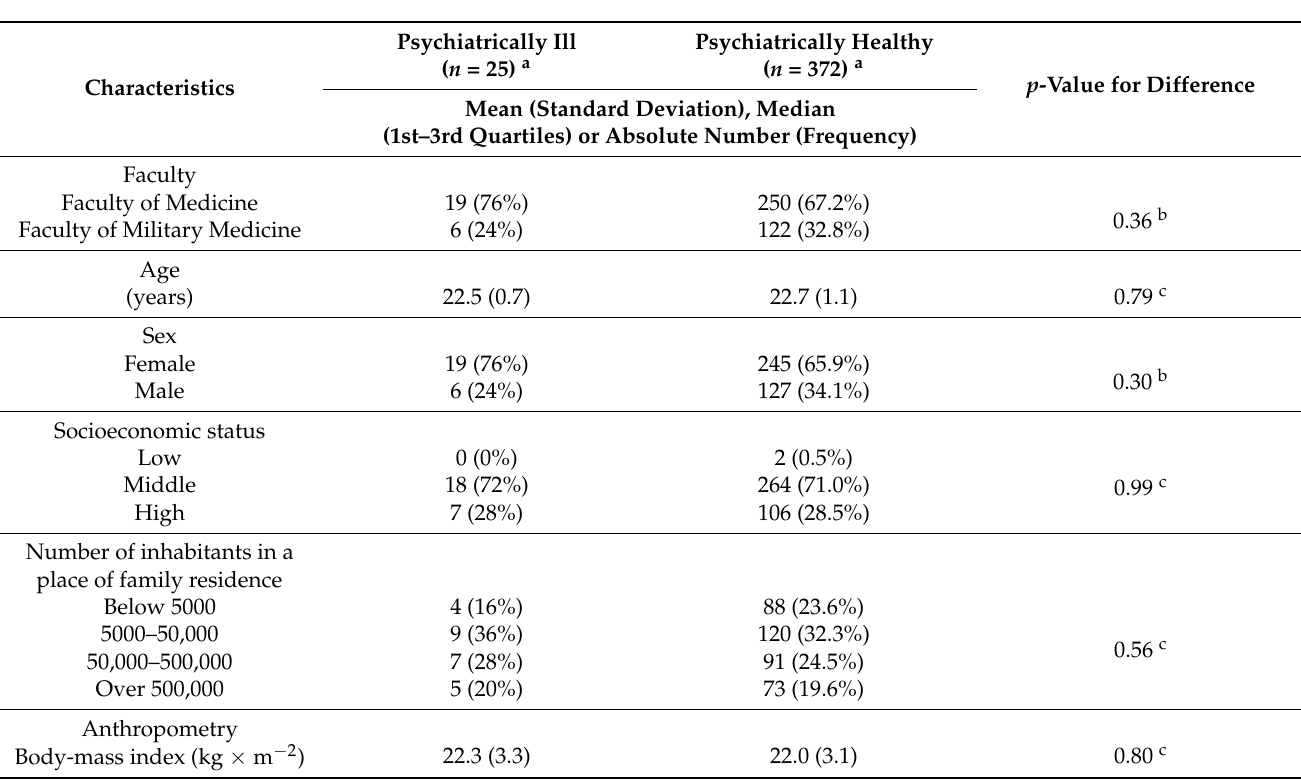
Table 1. Basal characteristics of the psychiatrically ill medical students compared to those of healthy